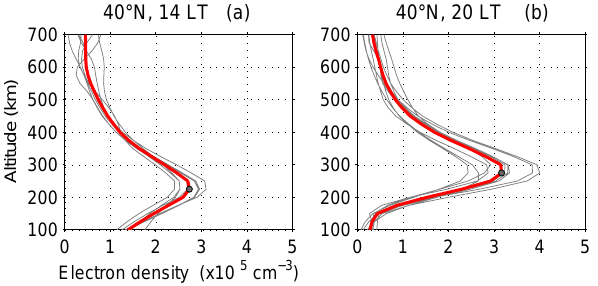
Fig. 3. Altitude profiles of electron density at 40 ◦ N, corresponding to 14:00LT and 20:00LT from tomography. The red curves indicate mean. The dot shows the maximum electron density.